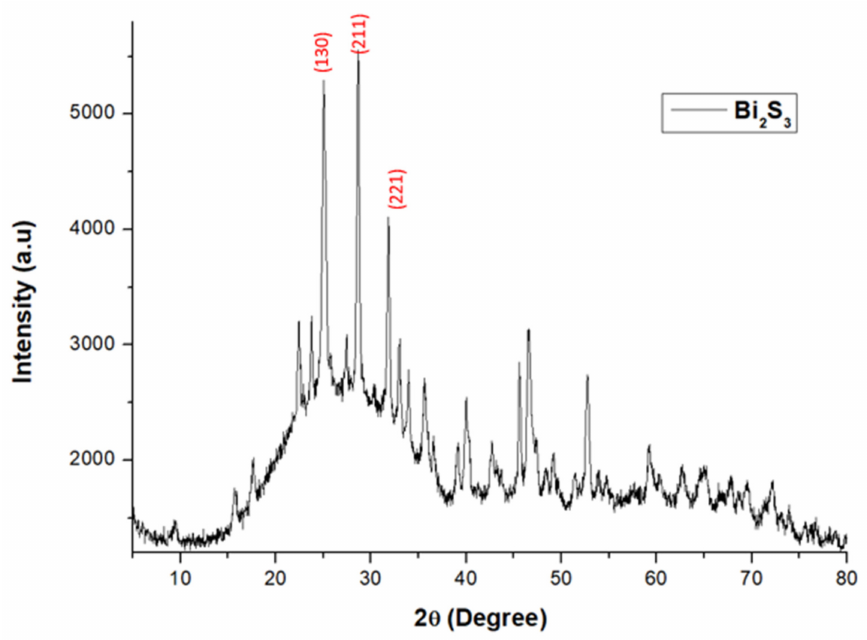
Figure 2. The XRD spectrum of bismuth sulphide. The prominent peaks are indexed in red